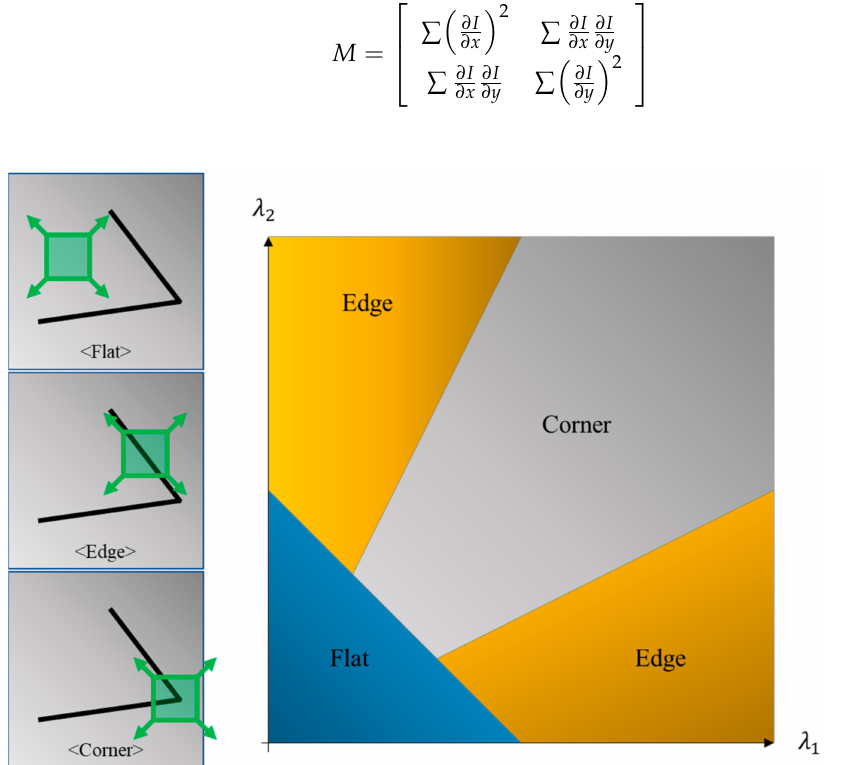
Figure 2. Corner type classification using the corner detection algorithm, and definition method for corner type using principal component of the matrix ( M ) .